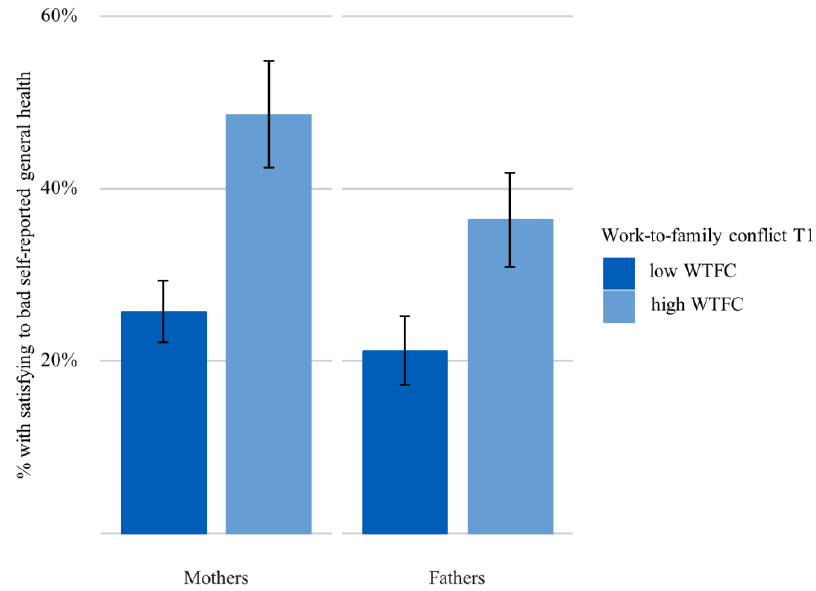
Figure 1. Percentage of parents with satisfying-to-bad self-reported general health (T1) by WTFC (T1), n = 791 mothers and n = 723 fathers, (prevalence in % and 95% CI (confidence interval)). Int. J. Environ. Res. Public Health 2020 , 17 , x